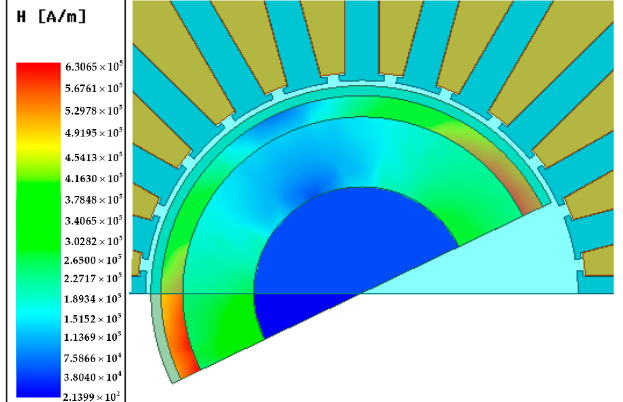
Figure 4. Result of eddy current loss analysis on the rotor.